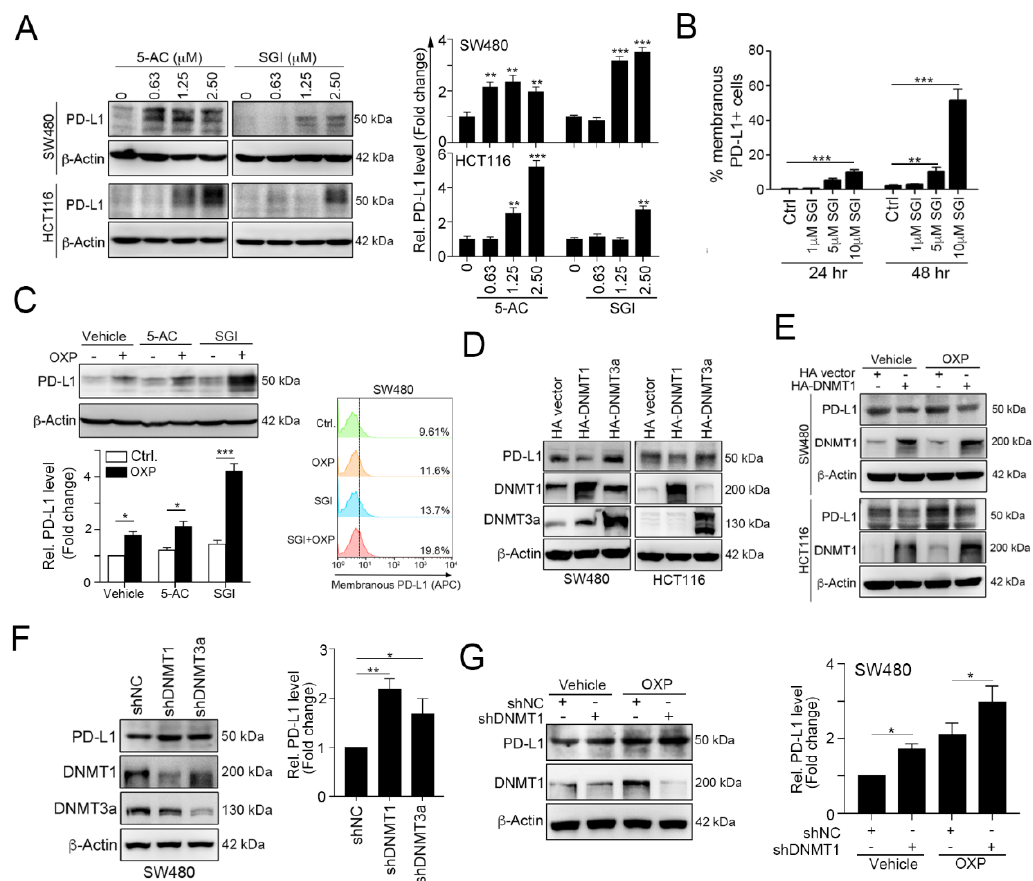
Figure 2. Epigenetic modifications mediated by DNA methyltransferase 1 (DNMT1) directly inhibits tumor PD-L1 expression. ( A ) SW480 and HCT116 cells were treated with the DNA hypomethylation inducers 5-azacytidine (5-AC) and SGI-1027 (SGI) for 24 h and then analyzed by immunoblotting. The quantification of these results is shown on the right ( n = 3); ** p < 0.01 and *** p < 0.001. ( B ) SW480 cells were treated with various concentrations of SGI-1027 for 24 and 48 h and then analyzed by flow cytometry. The quantification of these results is shown on the right ( n = 3); ** p < 0.01 and *** p < 0.001. ( C ) SW480 were simultaneously treated with OXP (10 µ M), 5-AC (2.5 µ M) and SGI (2.5 µ M) for 24 h and then analyzed by immunoblotting. SW480 cells were simultaneously treated with OXP (10 µ M) and SGI (2.5 µ M) for 24 h and then analyzed by flow cytometry. ( D ) SW480 and HCT116 cells were separately transfected with hemagglutinin (HA)-DNMT1 and HA-DNMT3a for 48 h and then analyzed by immunoblotting. The quantification of these results is shown in Figure S1. ( E ) SW480 and HCT116 cells were separately transfected with HA-DNMT1 for 24 h and then treated with OXP (10 µ M) for 24 h. Cell lysates were harvested and examined by immunoblotting. ( F ) SW480 cells were infected with a lentivirus carrying a negative control (NC), DNMT1 or DNMT3a shRNA. After selecting stable knockdown cells by puromycin selection, the cells were harvested and then analyzed by immunoblotting. The quantification of these results is shown on the right ( n = 3); * p < 0.05 and ** p < 0.01. ( G ) SW480-shNC and SW480-shDNMT1 cells were treated with OXP (10 µ M) for 24 h. Cell lysates were harvested and then analyzed by immunoblotting. The quantification of these results is shown on the right ( n = 3); * p < 0.05.